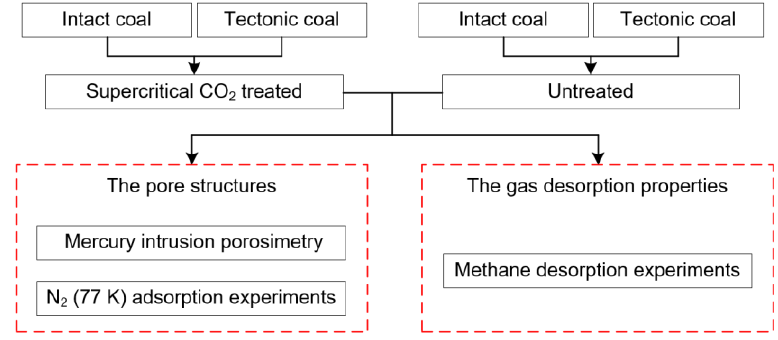
Figure 4. The whole experimental process.